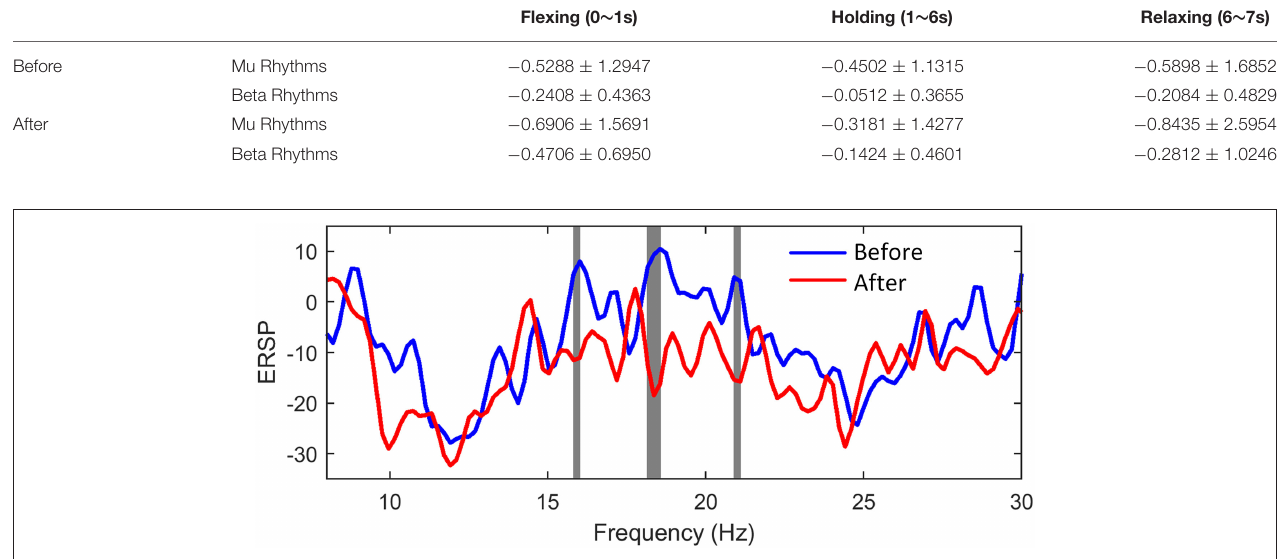
FIGURE 8 | The comparison of power changes of C3 EEG. The blue line indicates ERSP before NMES, while the red line indicates ERSP after NMES. The gray blocks present statistic significant differences ( p < 0.05) between ERSP before and after